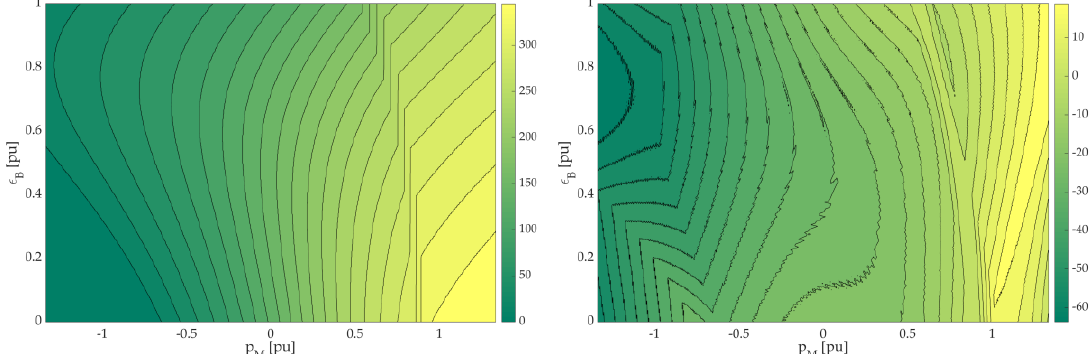
Figure 10. The optimal i FC ( left ) and i B ( right ) loci (in A) on the ( p M , ε B ) plane for v B = 0.